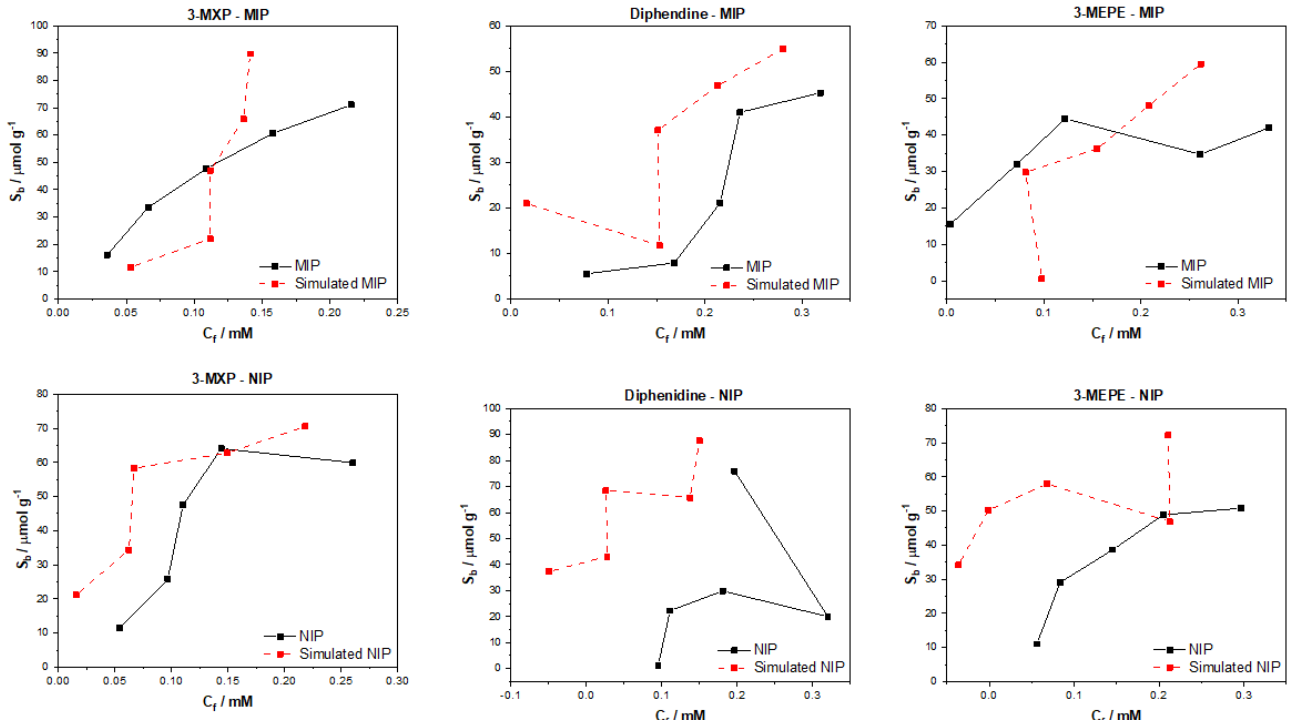
Figure 5. DAG simulated and experimental binding isotherms for MIP and NIP in regard to the binding of 3-MXP, diphenidine, and 3-MEPE.